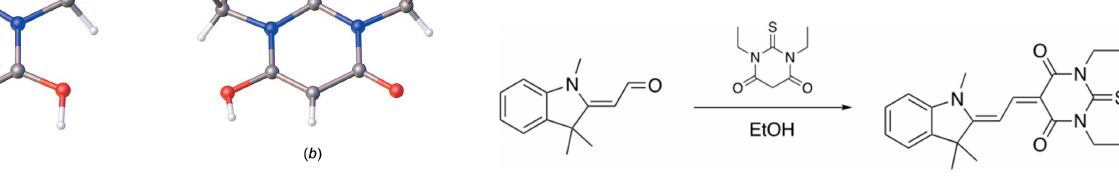
Figure 5 The molecular structures of compounds with an acceptor group very close to those in the chromophores reported here: ( a ) DETSBR01 (Bideau et al. , 1977) and ( b ) DETSBR11 (Padgett et al. , 2007).